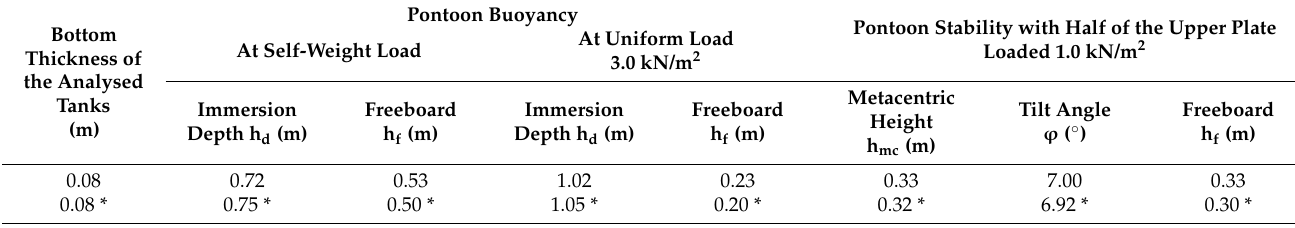
Table 2. Results of buoyancy and stability calculations made for the analysed tank. Bottom Thickness of the Analysed